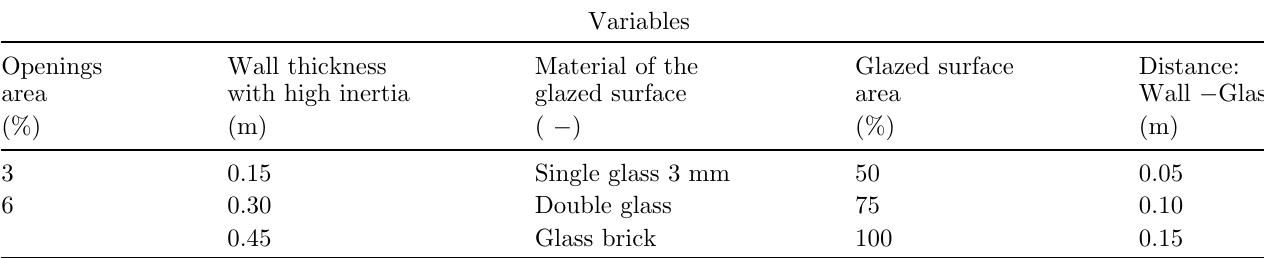
Table 2. Digital model ’ s variables.